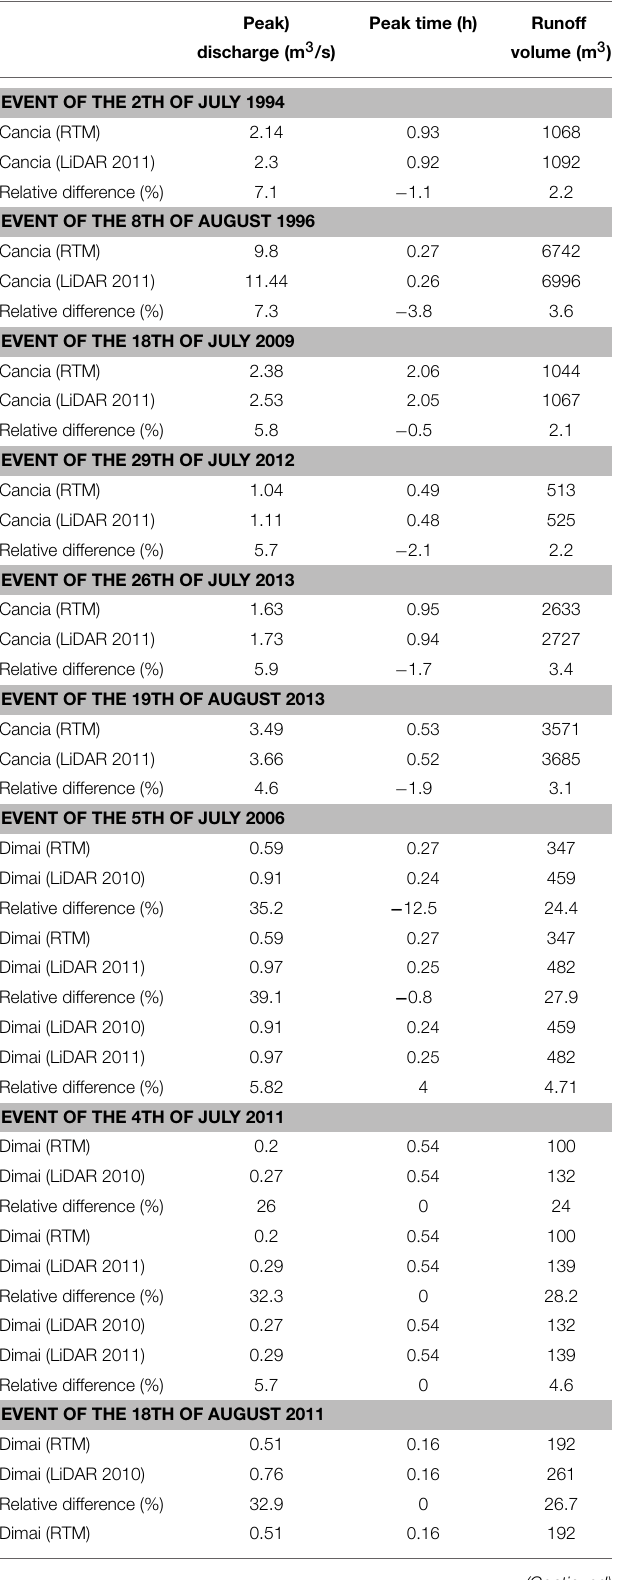
TABLE 3 | Quantitative results from hydrological